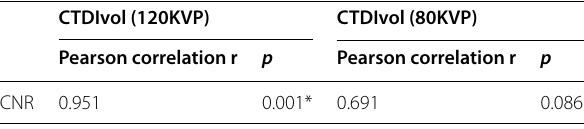
(mGY) and CNR vol